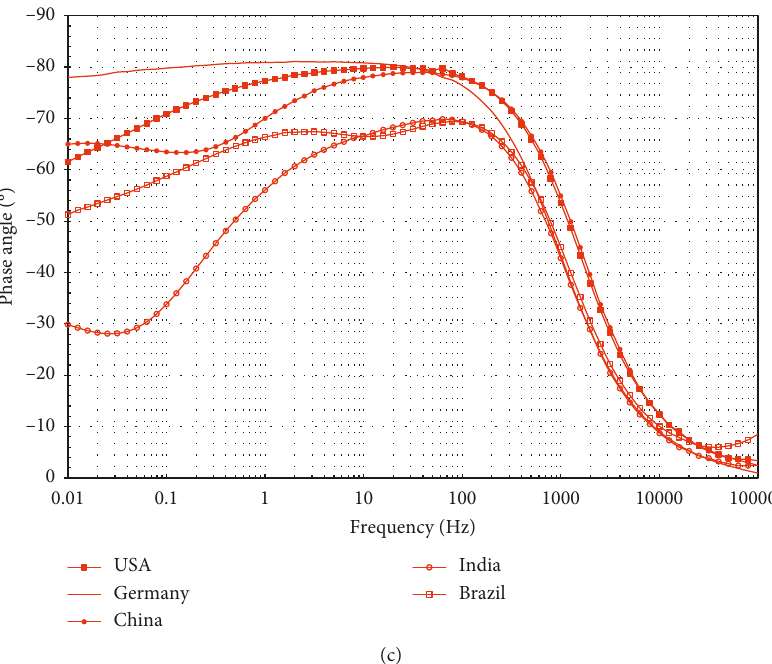
Figure 10: Electrochemical impedance spectra of the Ti6Al4V biomaterials after 100 hours of immersion in a 0.9% NaCl solution at 37 °